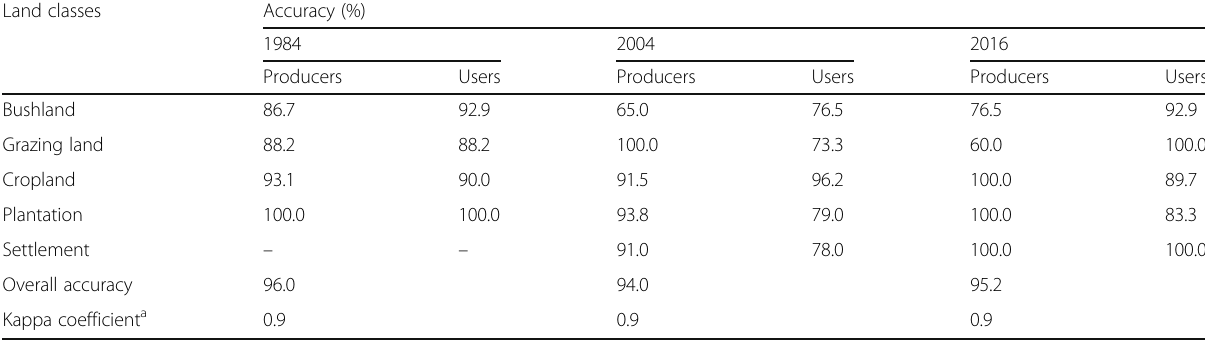
Table 1 Classification of accuracy value for LULC maps for the years 1984, 2004, and 2016 Land